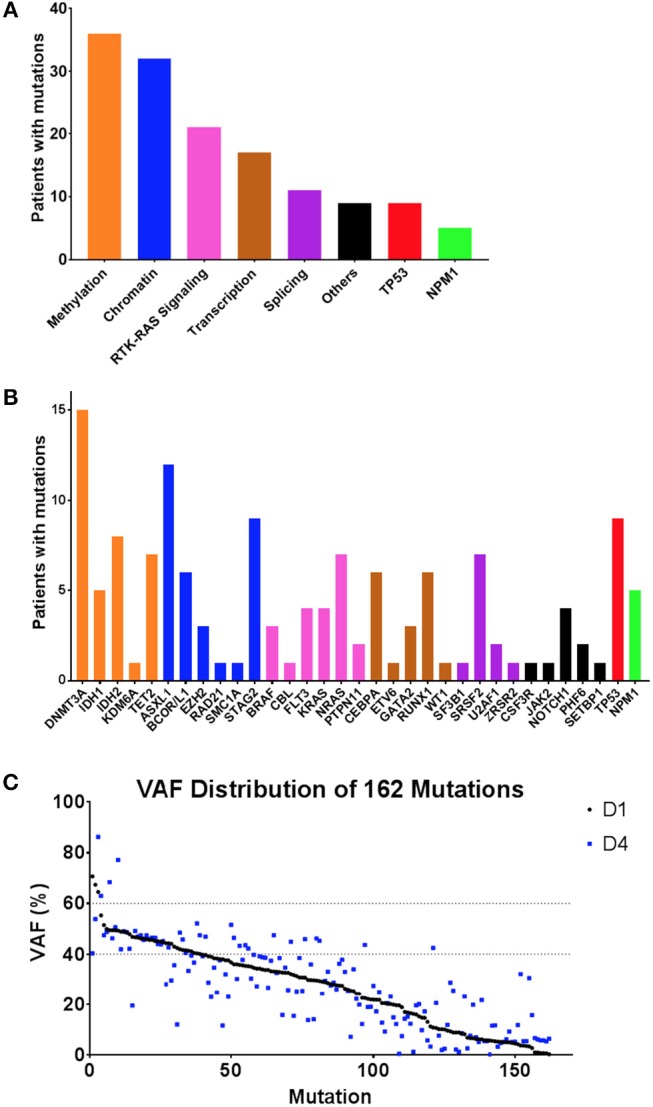
Summary of variants observed by DNA sequencing. (A,B) Frequency of variants summarized by gene function/class (A) and by individual gene name (B). (C) Variant allele frequency (VAF) distribution of variants detected in 43 patients by targeted DNA sequencing, sorted by VAF on day 1 (black), with VAF of same variant in same patient from day 4 also shown (blue). Day 1 variants had a median VAF of 29.24% (range: 0.19–78.94%) whereas Day 4 variants had a median VAF of 27% (range:0.14–86.28%).